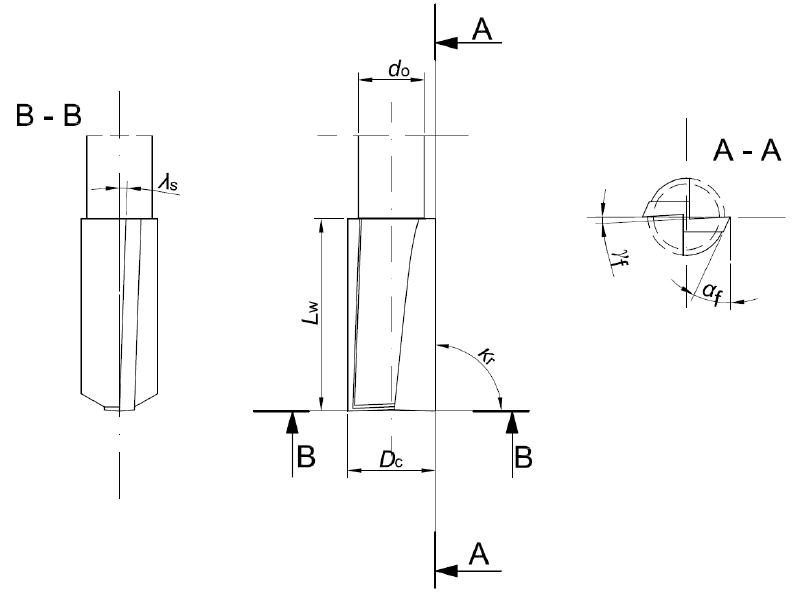
Figure 3. Cutting edge geometry of mill cutter used for wood milling process at the AX320 milling centre. Table 3. Main parameters of milling cutters and milling processes. Milling Cutters